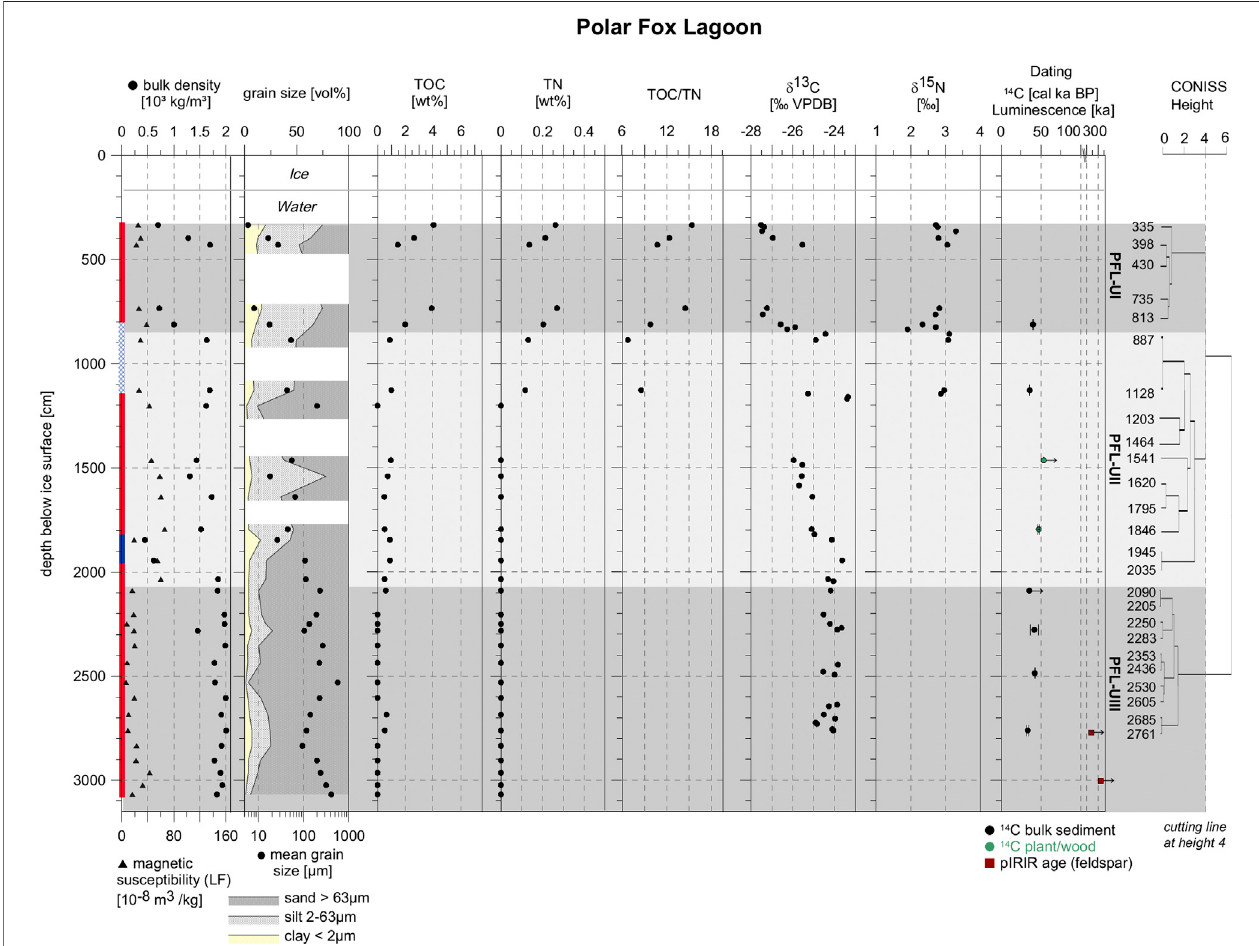
FIGURE 3 | Summary of sedimentological, geochronological and biogeochemical parameters for Polar Fox Lagoon core: bulk density (upper axis), mass speci fi c magneticsusceptibility(loweraxis),grainsize(upperaxis:volumetricproportions,loweraxis:meangrainsize),totalorganiccarbon content(TOC),totalnitrogen content (TN), organic carbon and nitrogen ratio (TOC/TN), stable carbon and nitrogen isotope composition ( δ 13 C, δ 15 N), radiocarbon dating ( 14 C) and luminescence dating (pIRIR). The top 330 cm is the overlaying ice and water layer. The core is divided into three stratigraphic units based on a CONISS analysis. Color bar at the y -axis indicates frozen (blue), unfrozen (red) and partially frozen (shaded) core segments. Arrows indicate non- fi nite ages.